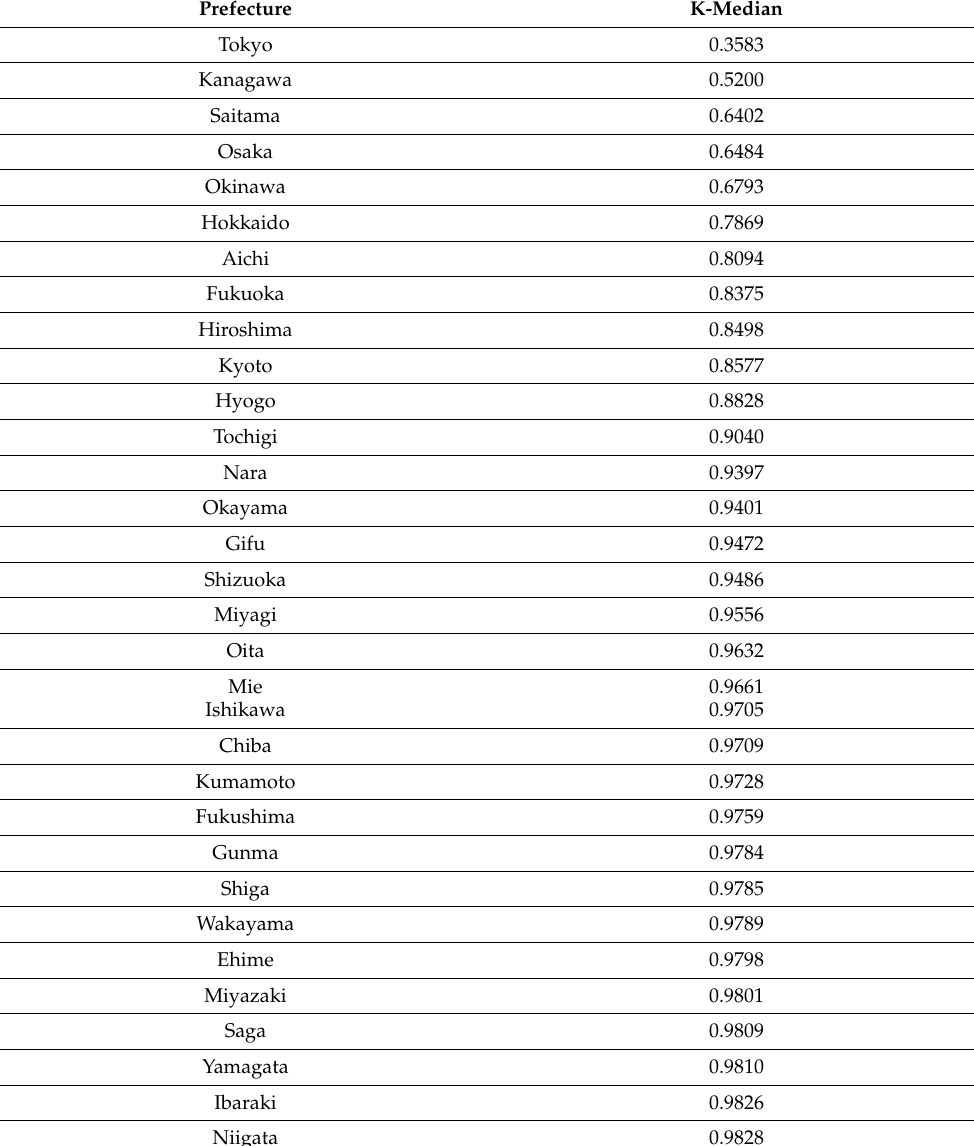
Table 2. K-median values for all prefectures of Japan for daily confirmed COVID-19